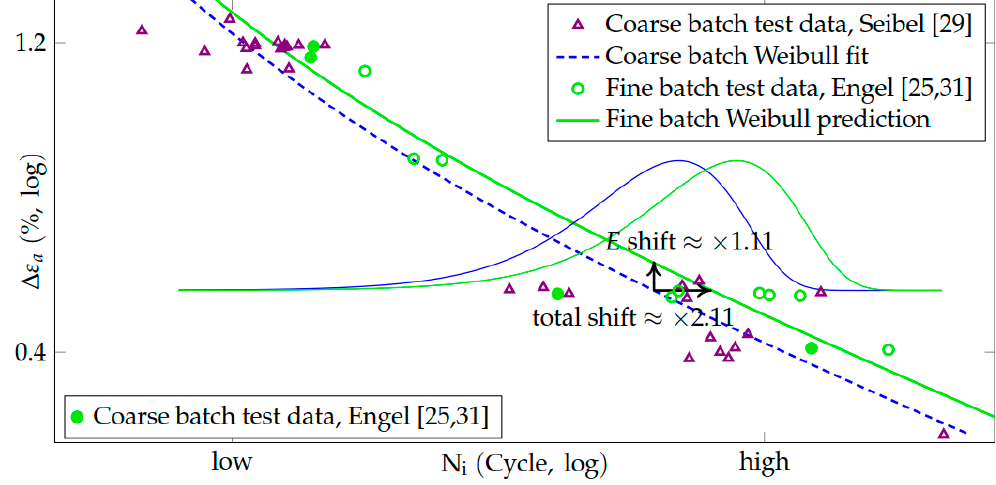
ffi n-Manson-Basquin life.